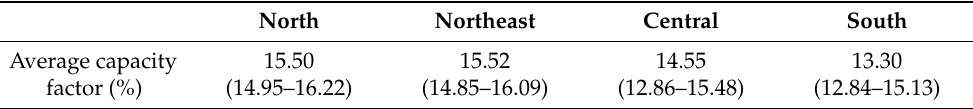
Table 1. Capacity factor by